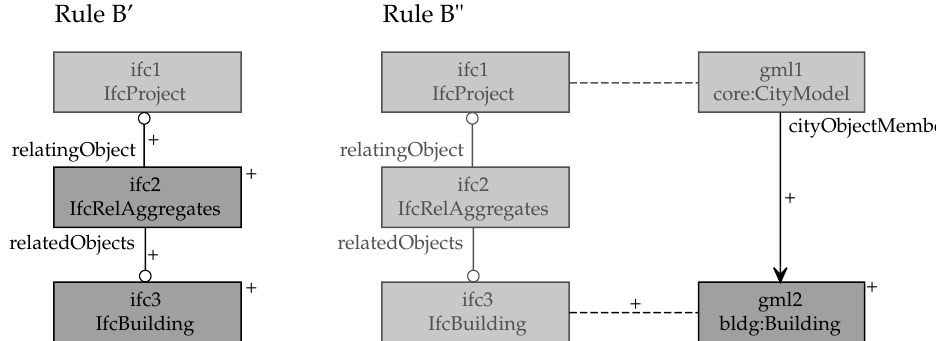
Figure 5. IFC-local rule B’ ( left ) and IFC → CityGML transformation rule B” ( right ) derived by splitting triple graph grammar rule B from Figure